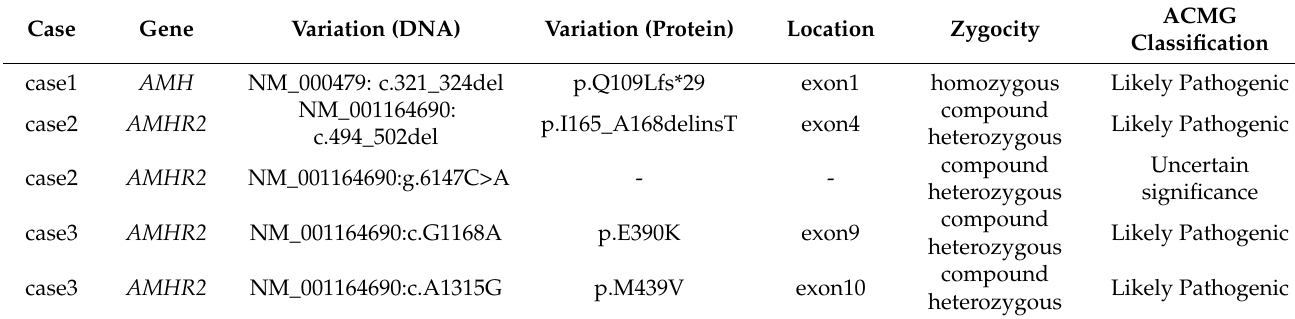
Table 1. The detected gene mutations of